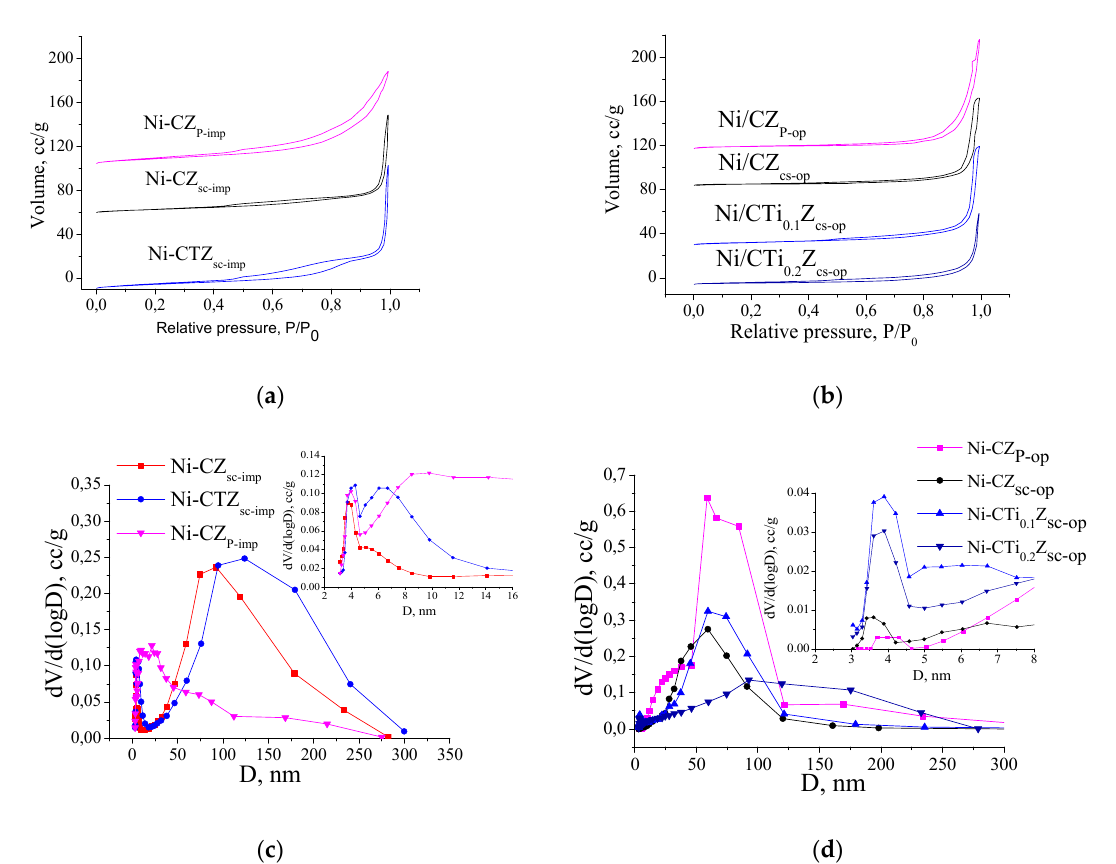
Figure 6. Adsorption–desorption isotherms and the pore size distribution of catalysts: ( a , c ) impregnated and ( b , d ) one-pot catalysts.